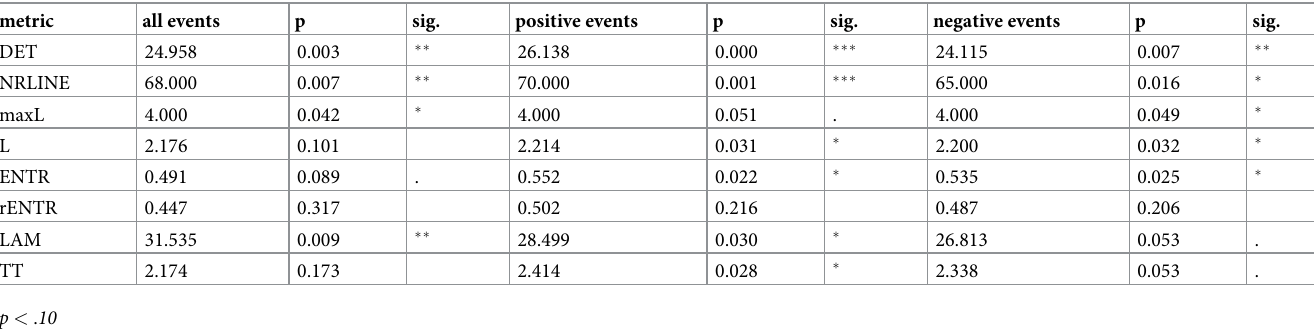
Table 3. CRQA results for original tweets and target-only data. metric all events